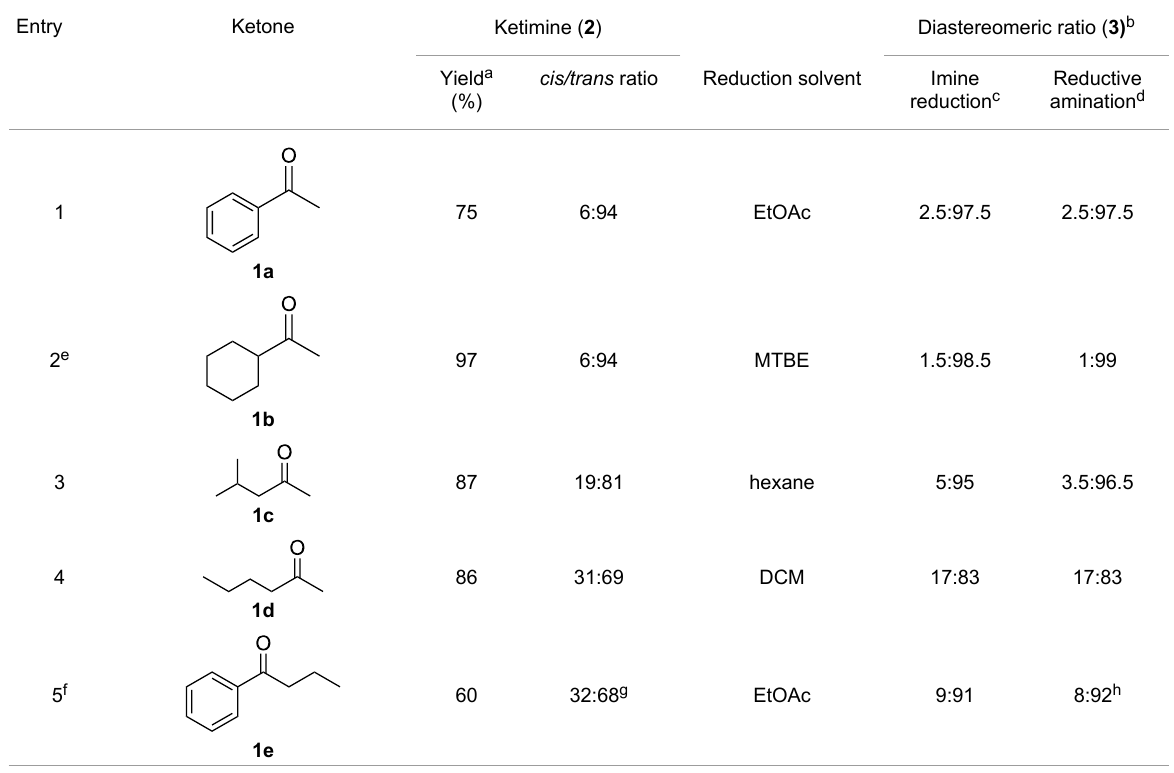
Table 1: ( S )-PEA imine yield and geometry, imine reduction data and reductive amination data with Raney-Ni.